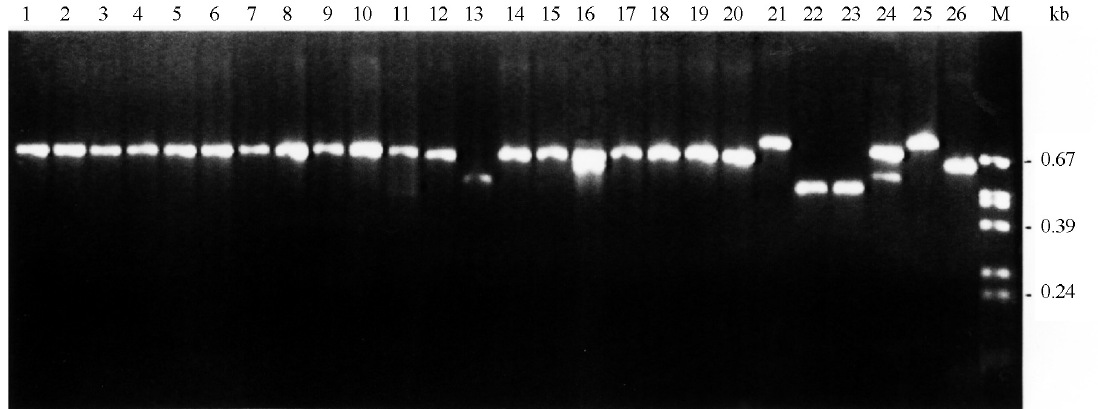
Figure 1 - Gel electrophoresis of the amplified rDNA internal transcribed sequence (ITS) region of 26 ectomycorrhizal fungal isolates. Lanes are num- bered according to the isolate identification scheme given in Table I. Size markers (pUC 19 digested with Hin f I and Rsa I) are indicated by